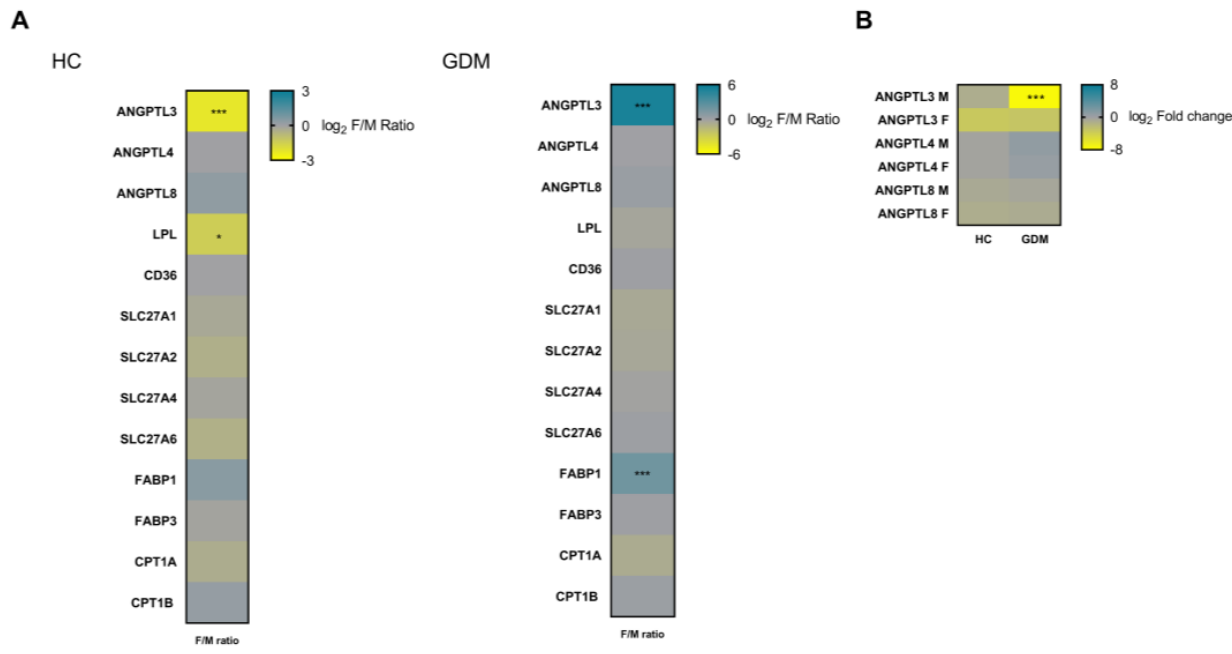
Figure 2. Comparison of gene expression in distinct parts of the placenta. ( A ) Heatmap comparing ANGPTLs, lipoprotein lipase and lipid transport gene expressions as a ratio between the fetal and maternal side of the placenta ( left panel ) in healthy control women ( n = 19 in each of them) and ( right panel ) in the gestational diabetes group ( n = 20). ( B ) Heatmap comparing ANGTPL3, 4 , and 8 expressions on both sides of the placenta according to glucose tolerance status (HC vs. GDM). Data are represented as log2 (F/M ratio) ( A ) and log2 (fold change) ( B ). Differences assessed by two-way ANOVA multiple comparison test, followed by Bonferroni correction. Data are normalized to intraindividual gene expression on the maternal side of the placenta ( A ) and to the mean of the control group for each gene and side ( B ) and are shown as means. M and F indicate gene expressions on the maternal and fetal sides of the placenta, respectively. * p < 0.05; *** p < 0.001. HC: healthy control; GDM: gestational diabetes. ANGPTL3: Angiopoietin-Like Protein 3; ANGPTL4: Human Angiopoietin-Like Protein 4; ANGPTL8: Human Angiopoietin-Like Protein 8; LPL: Lipoprotein Li- pase, CD36: Cluster of Differentiation 36; SLC27A1, SLC27A2, SLC27A4, and SLC27A6: Solute Car- rier Family 27 Members 1, 2, 4, and 6, respectively; FABP1 and FABP3: Fatty Acid Binding Proteins 1 and 3, respectively; CPT1A and CPT1B: Carnitine Palmitoyltransferase 1A and 1B, respectively.